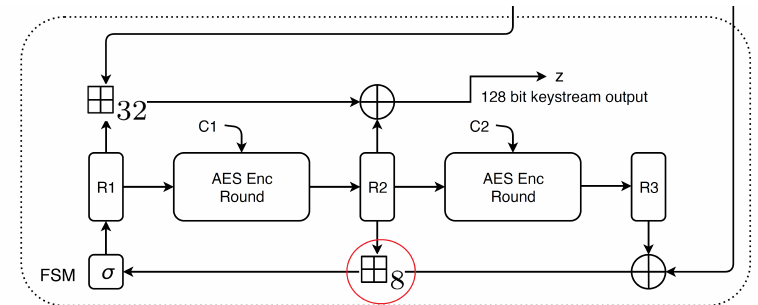
Figure 5: The FSM part of SNOW-V (cid:1)